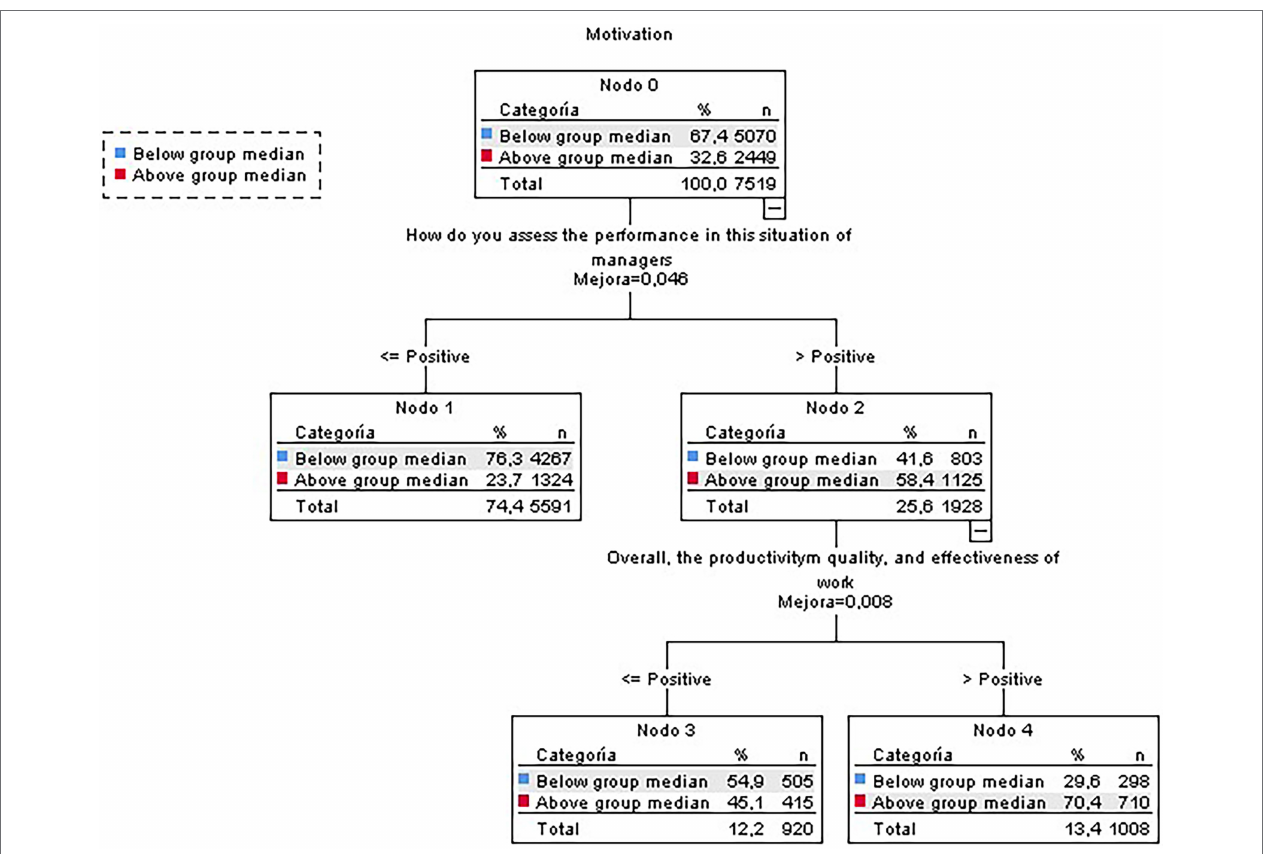
FIGURE 2 | Classification tree for motivation (teleworkers